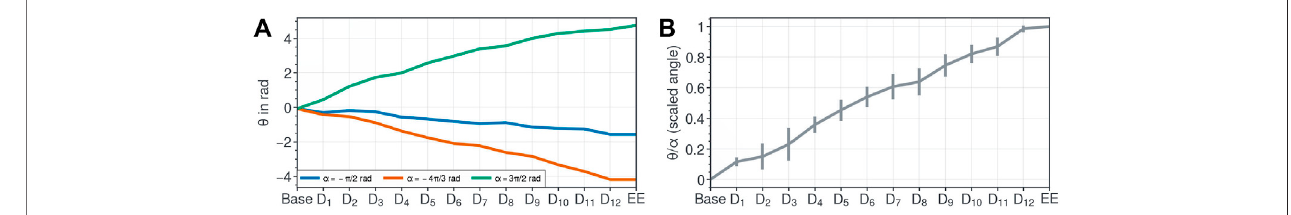
FIGURE5| Courseofdiskorientationfortendonroutingassessment.Orientationsinradofeachdisksindicateahelicaltendonrouting. (A) Threedifferentrotations of the end disk EE (type-0 FSD) causing change of the orientation of each disk D i , where D 1 is the proximal type-III FSD, D 1 is the distal type-III FSD, and all other type-III FSD areinbetweenwithincreasing i .Theblue, red,and greencurvecorresponds todiskrotationinduces by α = − π /2rad, α = − 4 π /3 rad,and α =3 π /2rad, respectively. (B) Normalized angles of the three different rotations indicate a linear trend.